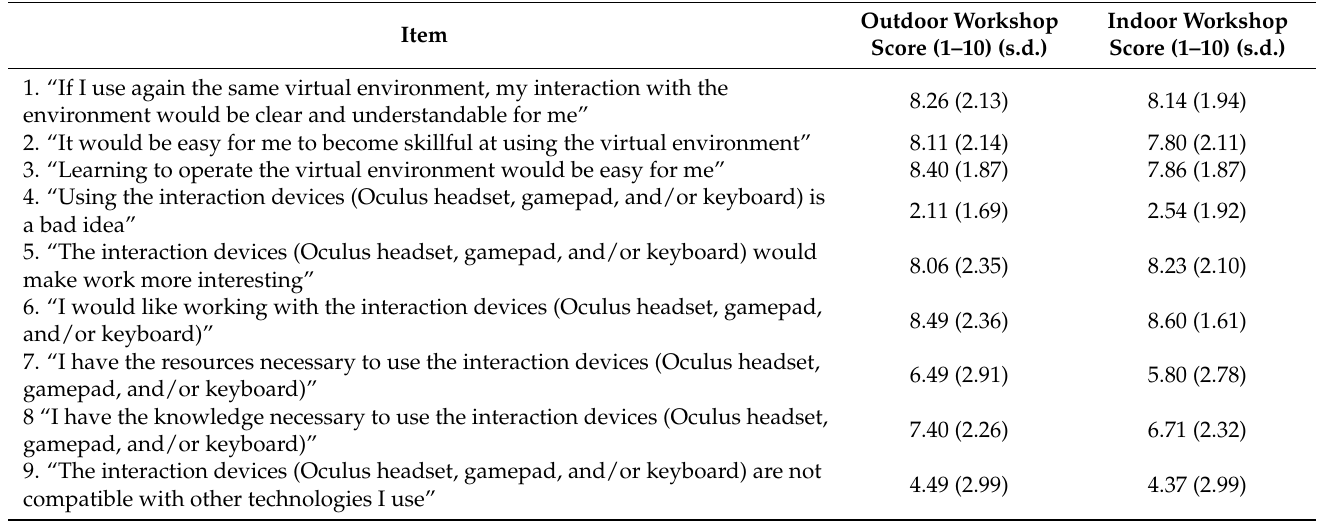
Table 11. Questionnaire on User experience in Immersive Virtual Environments: technology adop- tion